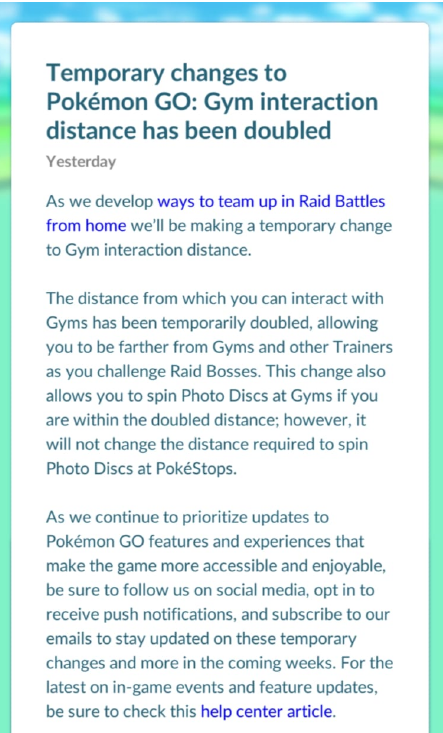
Figure 2. A screenshot taken by authors about an update issued on Pokémon GO to combat